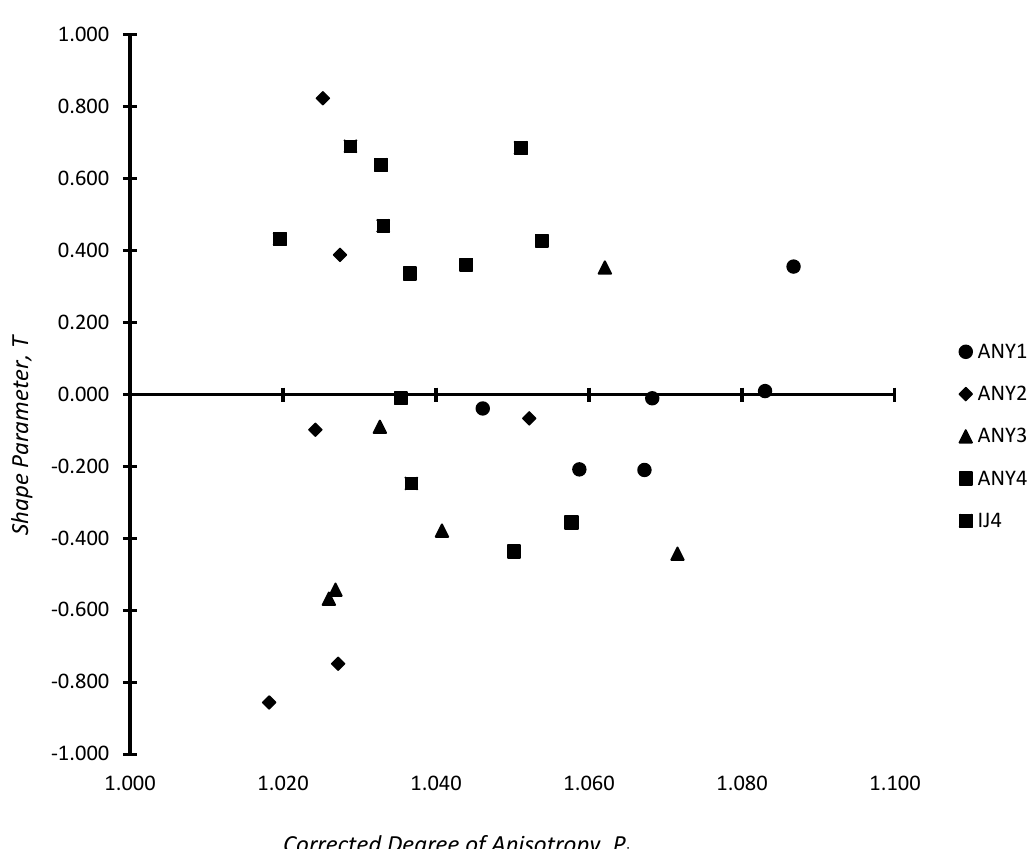
Figure 2. A plot of shape parameter ( T ) and the corrected degree of anisotropy ( P j ). Positive values indicate an oblate shape, whereas negative values indicate a prolate shape.